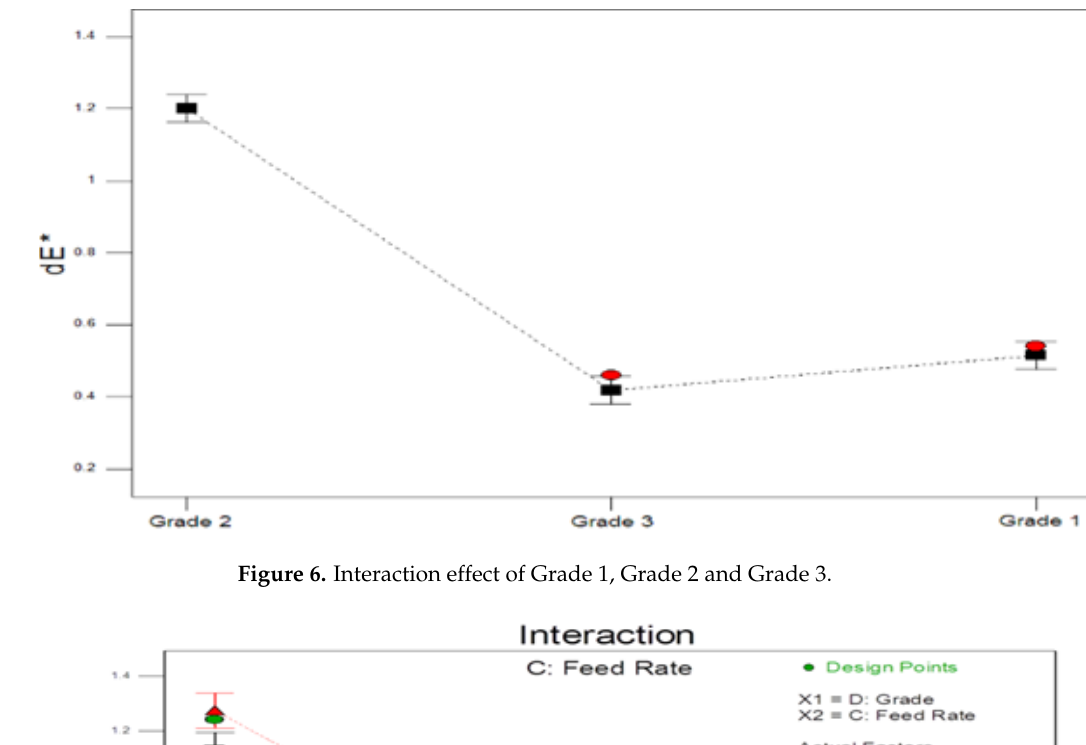
Figure 5. Effect of processing parameters on grade 3, L*.